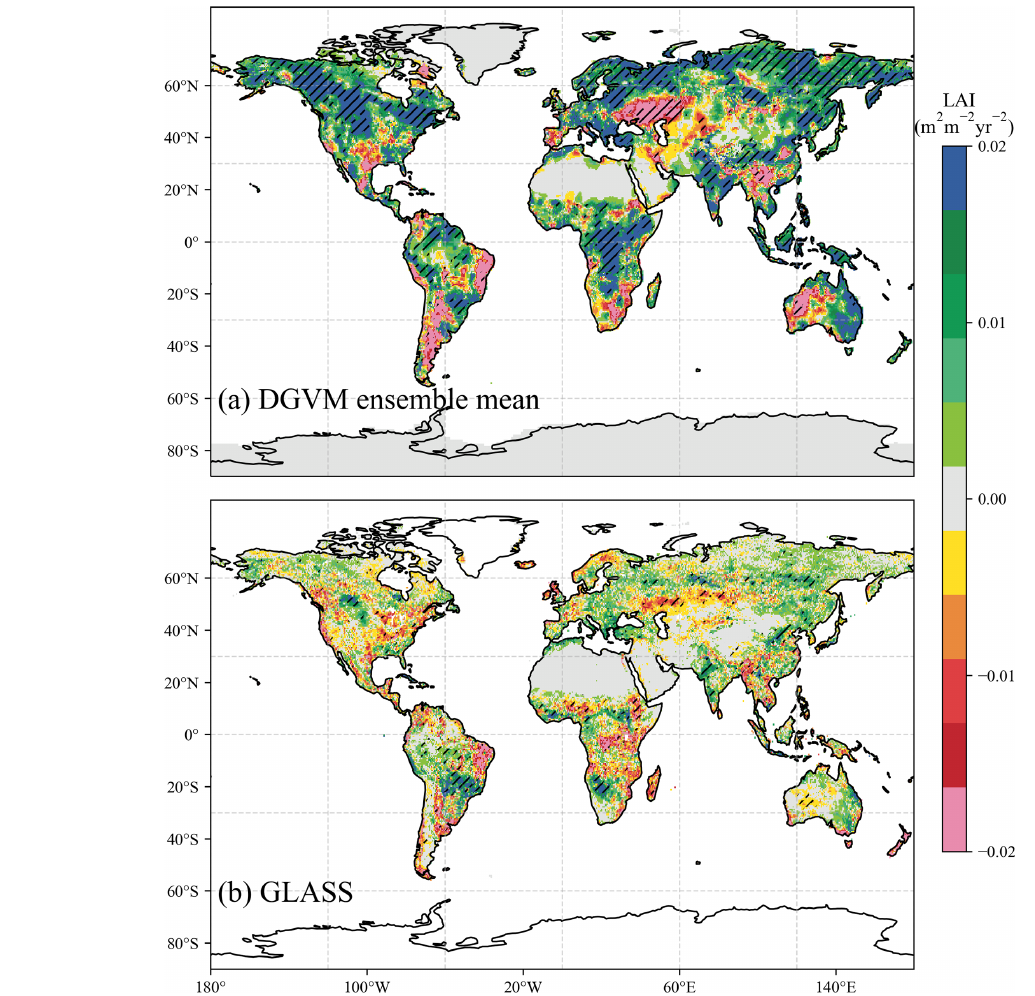
Figure 6. The spatial distributions of LAI trends (m 2 m − 2 yr − 2 ) from the (a) DGVM ensemble mean and (b) GLASS from 2001 to 2015. Striped areas indicate that the trend is significant with p < 0 . 05 following the non-parametric Mann–Kendall trend